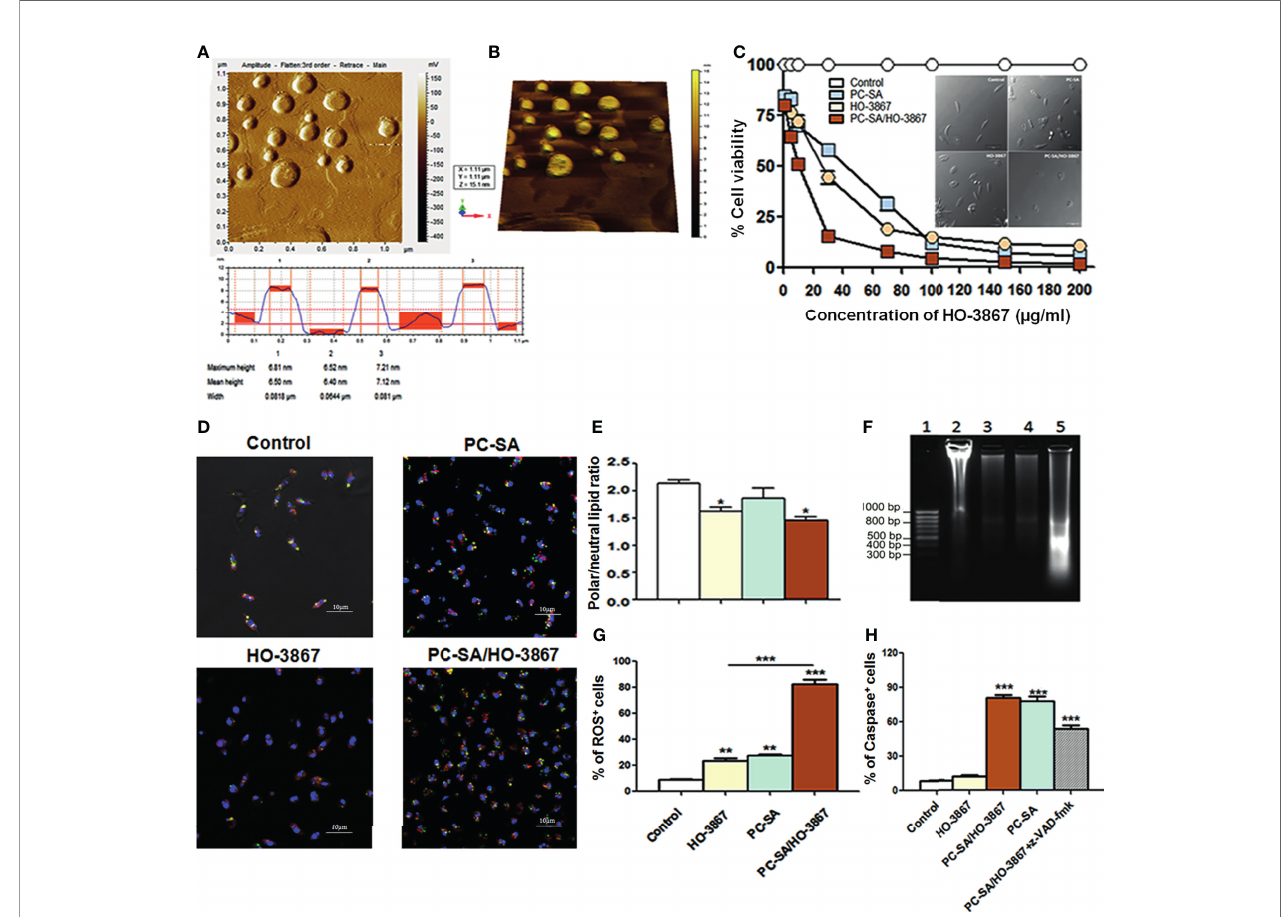
FIGURE 1 | Vesicle morphology and effect of liposomal HO-3867 on L. donovani promastigotes 2 h post-treatment. (A) Tapping mode AFM images of PC-SA/HO-3867 liposomes. Topography is indicative of the height of the liposomes from the mica base. (B) Representative three-dimensional AFM image of PC-SA/HO-3867 liposomes. (C) Effect of increasing concentrations of empty liposomes and free and liposomal HO-3867 on viability of log-phase promastigotes estimated by MTT assay. Inset depicts the morphological alterations of control, empty PC-SA liposomes (10 µg/ml w.r.t PC), and drug-treated promastigotes under a phase-contrast microscope. (D) Nile Red (NR)- fl uorescent quanti fi cation of polar (orange-red) and non-polar (yellowish green) lipid accumulation in promastigotes with or without free and liposomal HO-3867 treatment. (E) Representative bar diagram showing the ratio of polar/non-polar (i.e., red/green) lipids in differently treated promastigotes. (F) DNA fragmentation in promastigotes treated with IC 50 dose of PC-SA/HO-3867, free HO-3867, and PC-SA liposomes. Lane 1, GeneRuler 50-bp DNA ladder (Thermo); Lanes 2 – 5, untreated, promastigotes treated with 10 µg/ml offree HO-3867, PC-SA liposomes, and liposomal HO-3867, respectively. (G) Intracellular ROS generation in log-phase promastigotes after treatment with free and liposomal HO-3867, by H 2 DCFDA. (H) Bar graph showing means of caspase-positive cells in differently treated and untreated parasites, in absence or presence of pan- caspase inhibitor z-VAD-fmk, as analyzed by fl ow cytometry. Each data represent mean ± S.E. (n = 3) and is one of the three experiments with similar results. * p < 0.05; ** p < 0.001; *** p < 0.0001, as assessed by one-way ANOVA and Tukey ’ s multiple-comparison